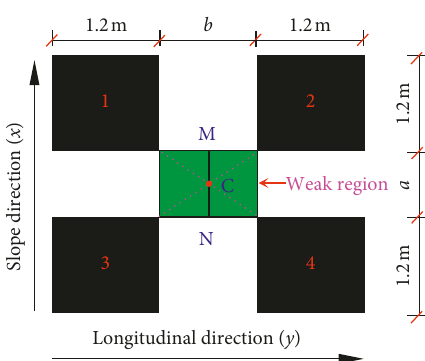
Longitudinal direction ( y Figure 21: Spacing parameters of the lateral pressure